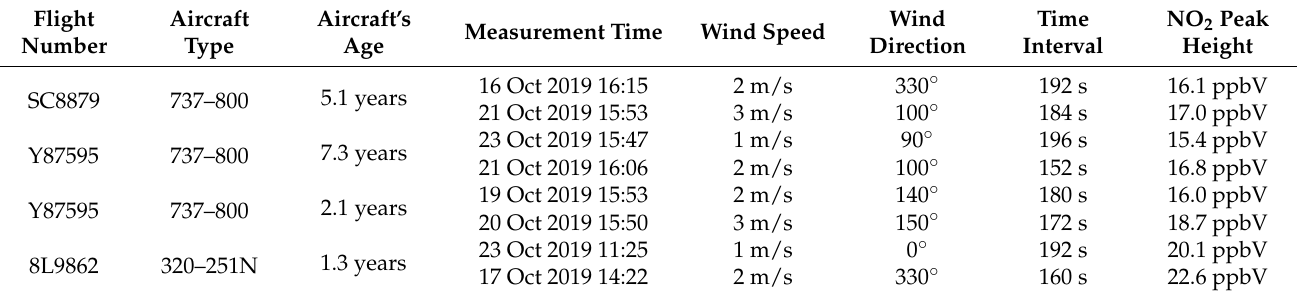
Table 2. Identical aircraft emissions data with different meteorological